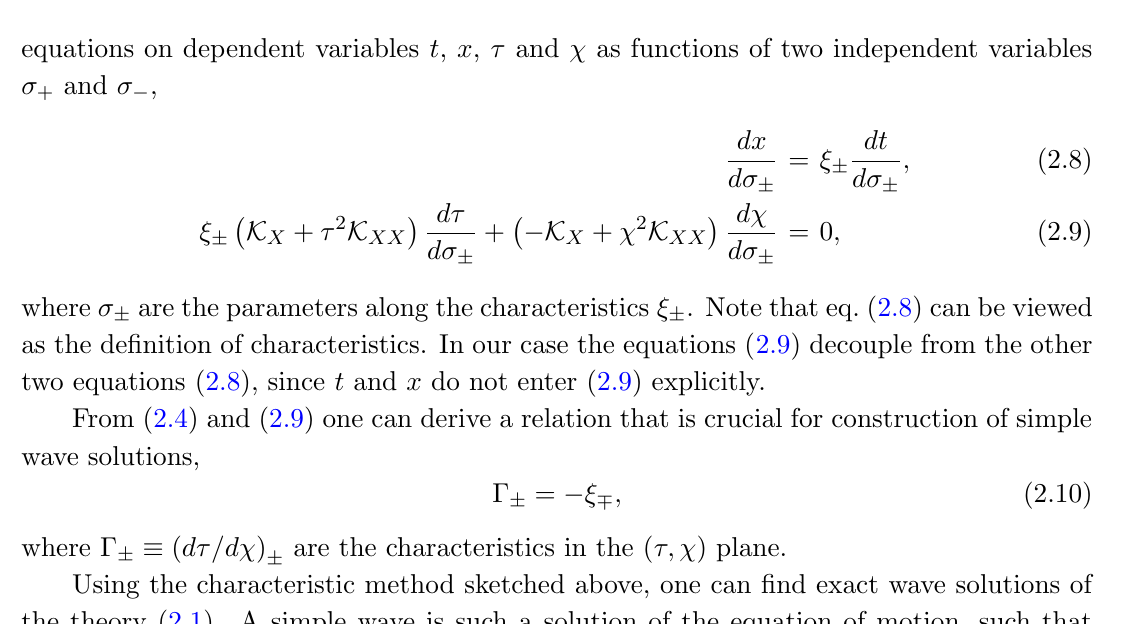
Figure 1 . The solution of a simple right moving wave is shown. In the left panel the solution is shown in the ( (cid:28); (cid:31) ) plane. The solution completely lies on a singe characteristic (cid:0) (cid:0) . The same solution is shown in the right panel in the physical space. The right propagating characteristics (cid:24) + are straight and non-parallel lines, resulting in their intersection (red star) where a caustic is